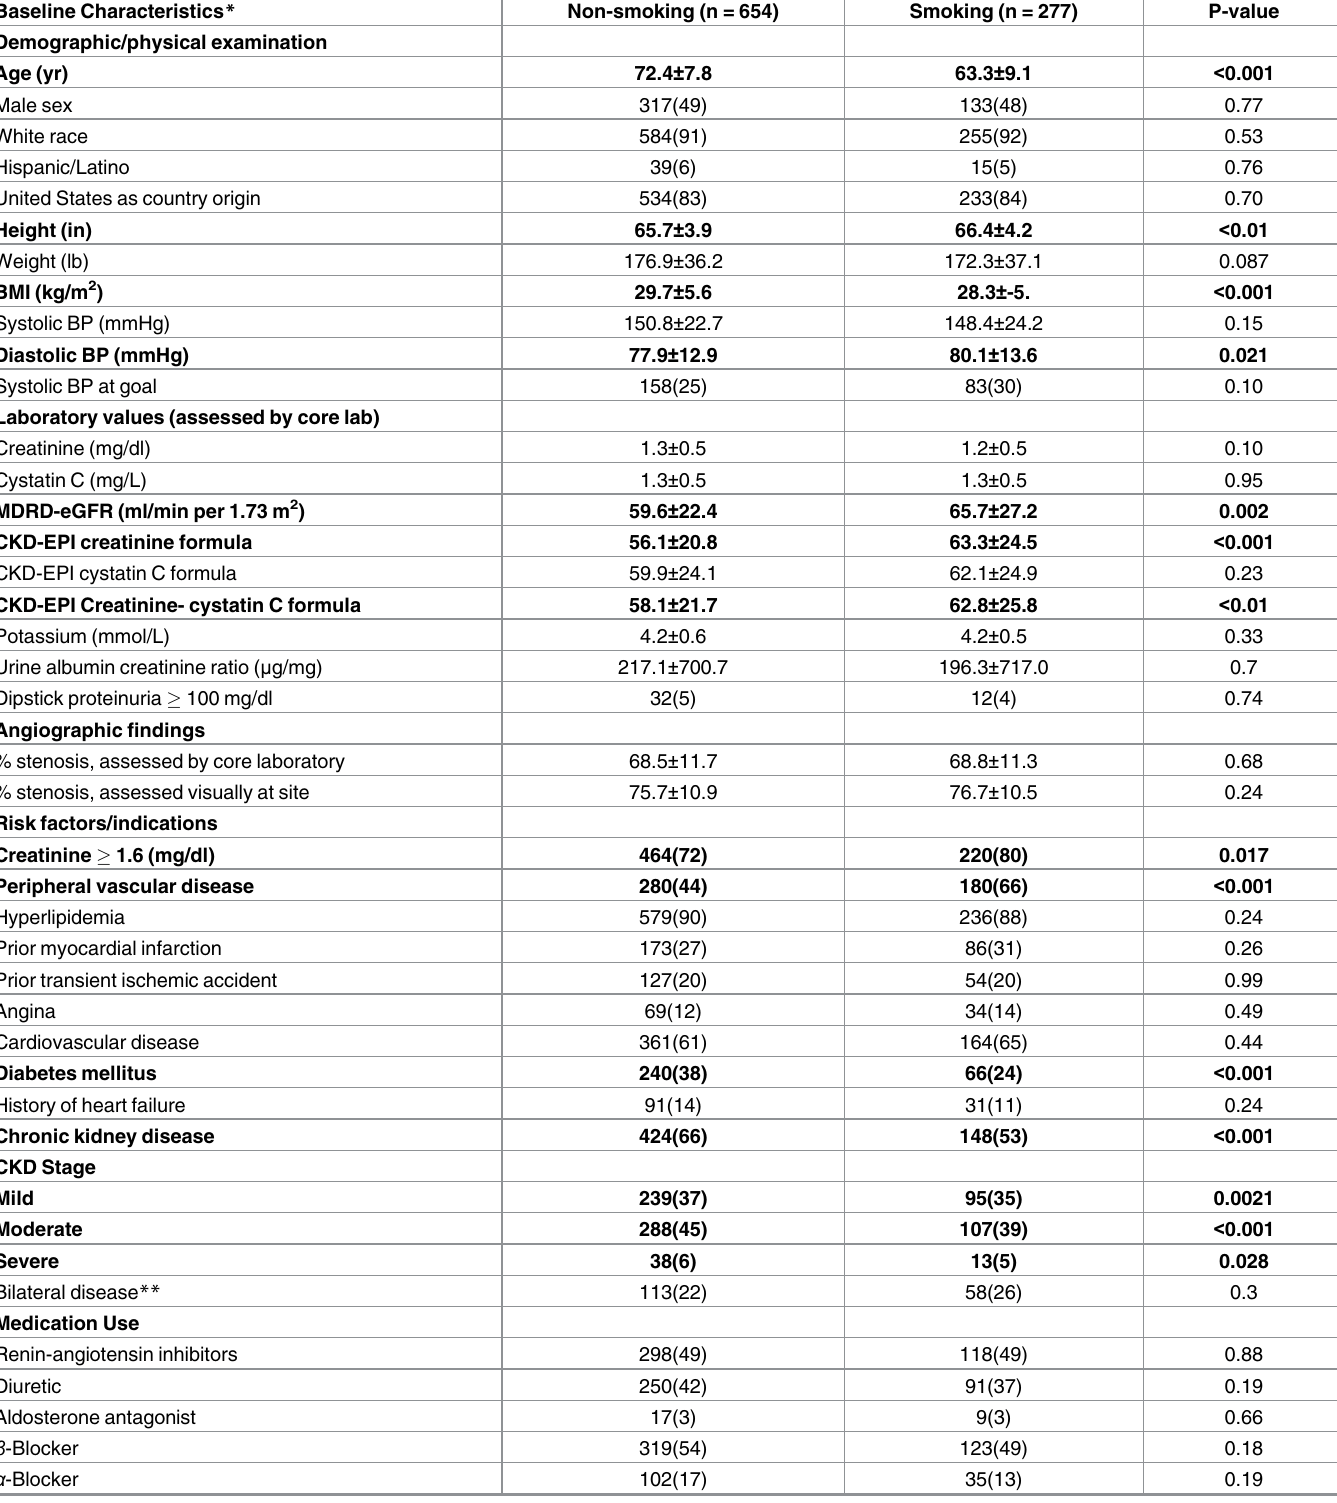
Table 1. Baseline clinical characteristics comparisons by smoking status within the last